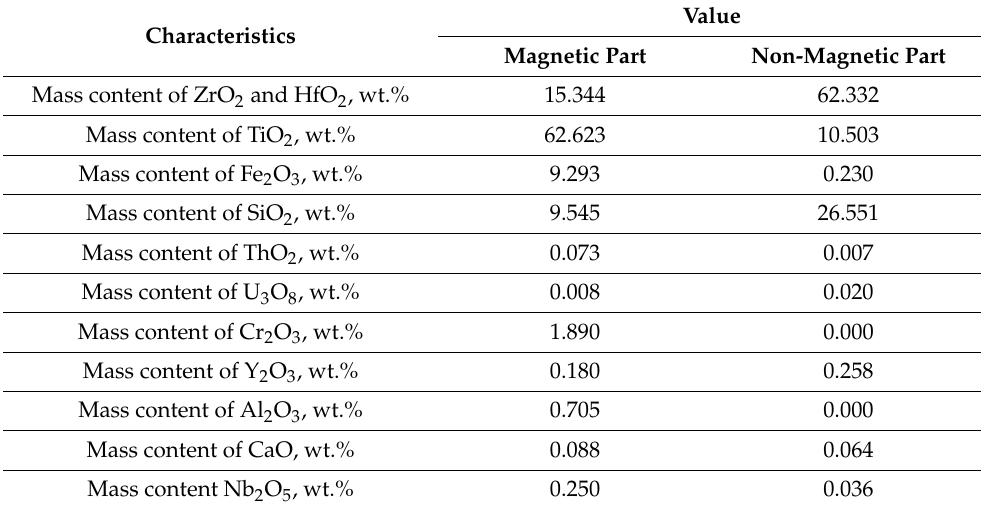
Table 9. Chemical composition of fraction 6. Characteristics